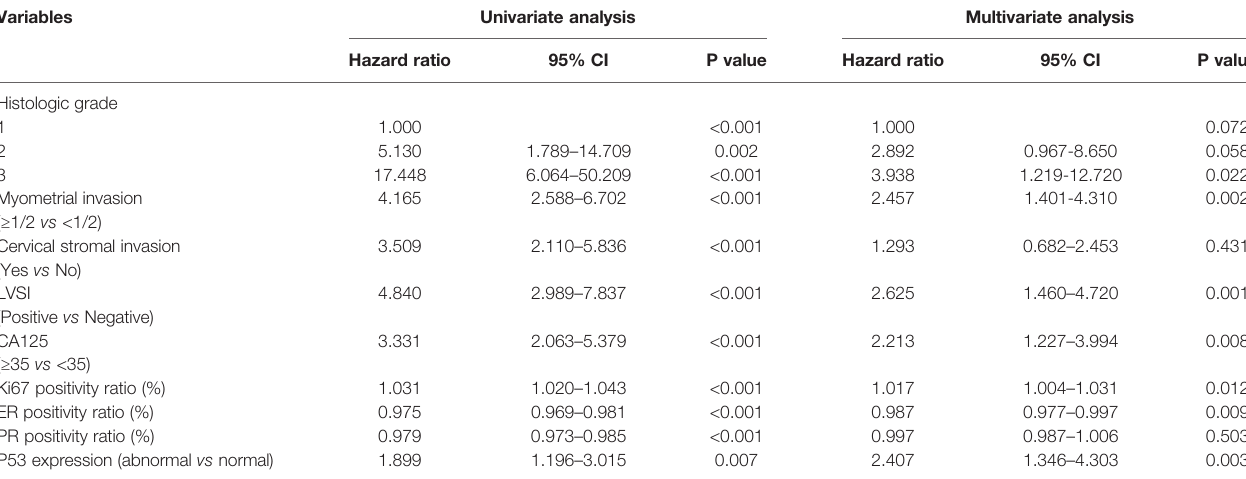
TABLE 2 | Univariate and multivariate analyses of predictive factors for lymph node metastases in the training cohort.